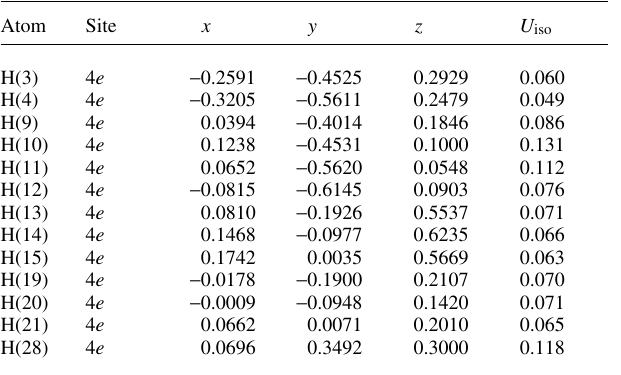
Table 2. Atomic coordinates and displacement parameters (in Å 2 )